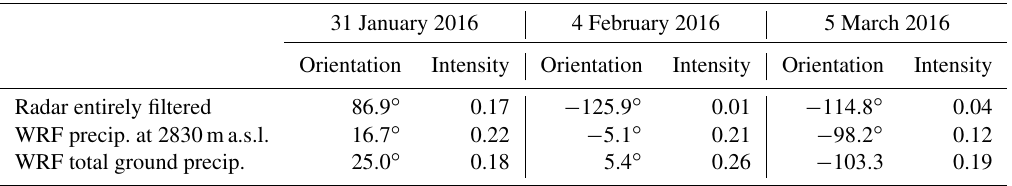
Table 2. Large-scale linear trends of entirely filtered radar and WRF precipitation patterns on the regional domain (450m horizontal grid spacing, Fig. 1). WRF precip. at 2830ma.s.l. refers to solid precipitation in WRF simulations at 2830m above sea level and WRF total ground precip. refers to the total (solid and liquid) precipitation at the ground level. Orientation gives the direction of the slope and intensity the strength of inclination. A value of 0 ◦ would indicate a slope pointing toward the east. WRF snow precipitation is from simulations with weak terrain smoothing (Sect.